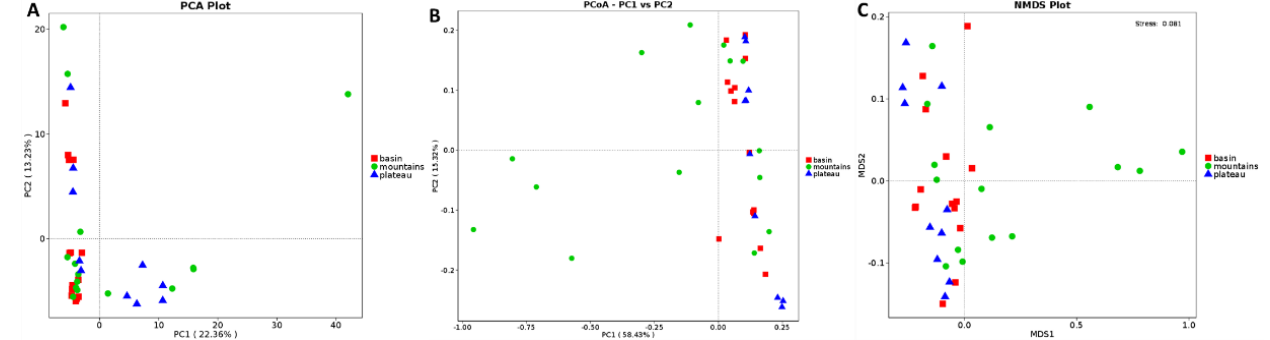
Figure 3. The beta diversity of the 39 bacons at the genus level (PCA ( A ), PCoA ( B ), and NMDS ( C ) scores plotted based on Figure 3 . The beta diversity of the 39 bacons at the genus level (PCA ( a ), PCoA ( b ), and NMDS ( c ) scores plotted based on Weighted Weighted Unifrac).